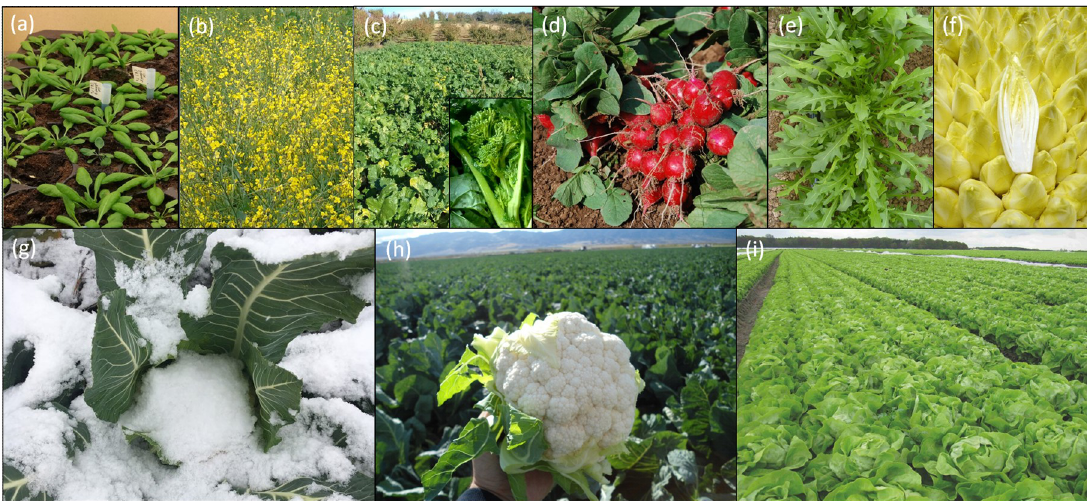
Figure 1. Plant species considered in this review. ( a ) Arabidopsis thaliana , ( b ) Brassica napus (rapeseed), ( c ) Brassica rapa (turnip), ( d ) Raphanus sativus (radish), ( e ) Diplotaxis tenuifolia (wild rocket), ( f ) Cichorium intybus (chicory), ( g ) Brassica oleracea (cauliflower) in winter, ( h ) Brassica oleracea (cauliflower) in summer and ( i ) Lactuca sativa (lettuce).